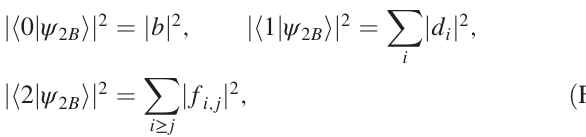
2 versus position for i j 2 as a function of i and j for i;j j as a function of bare qubit tot